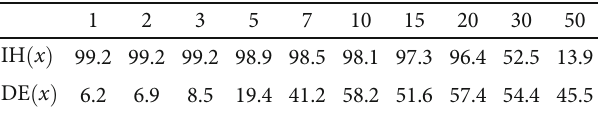
Table 3: Original data for calculation of IH ð x Þ and DE ð x Þ